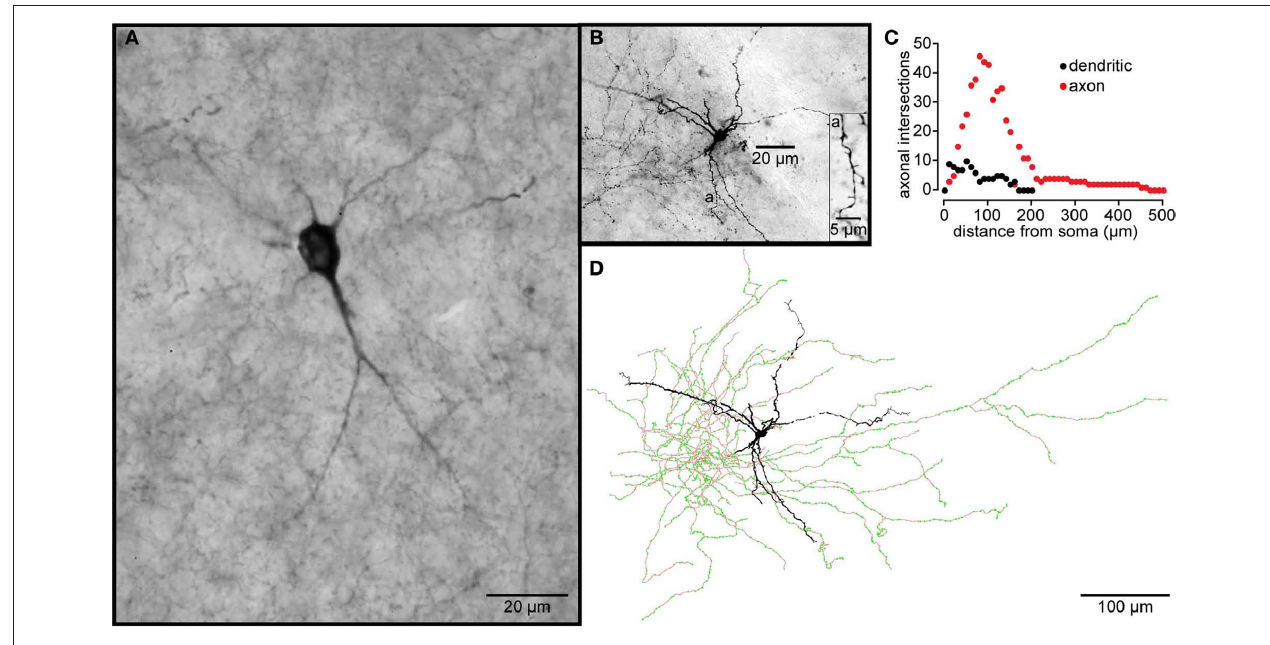
appendages ( a ). (C) Shows a Sholl plot of the reconstructed neuron revealing the extents and close overlap of the dendritic and axonal arborizations. (D) Drawing tube reconstruction of the neuron shown in (B) . Note the dense axonal arborization studded with varicosities (green dots), presumably axonal